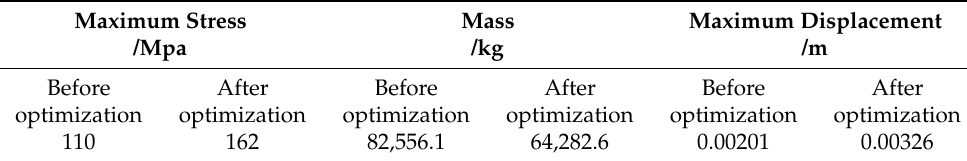
Table 6. Comparison of structural stress and displacement before and after optimization.